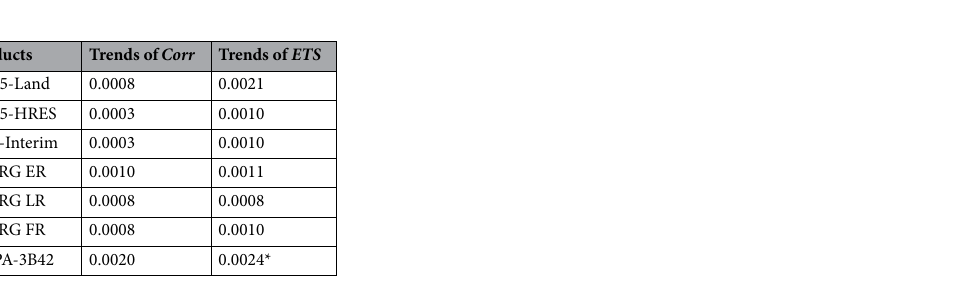
Table 4. Linear regression trends and corresponding significance of Corr and ETS for precipitation products from 2001 to 2018 (*p <